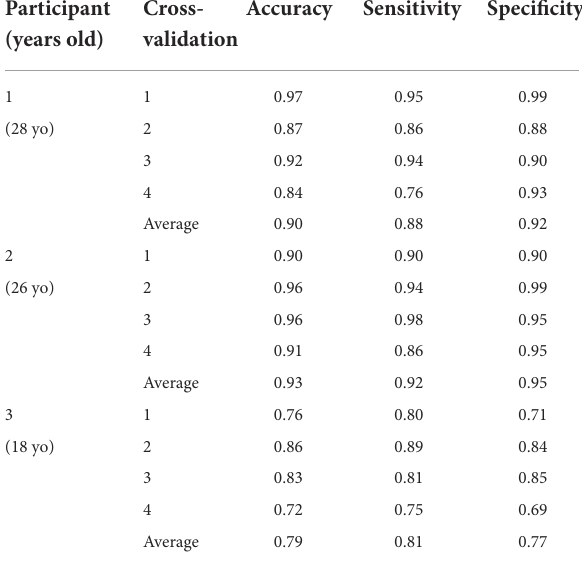
TABLE 1 Offline performance of classifiers in 4